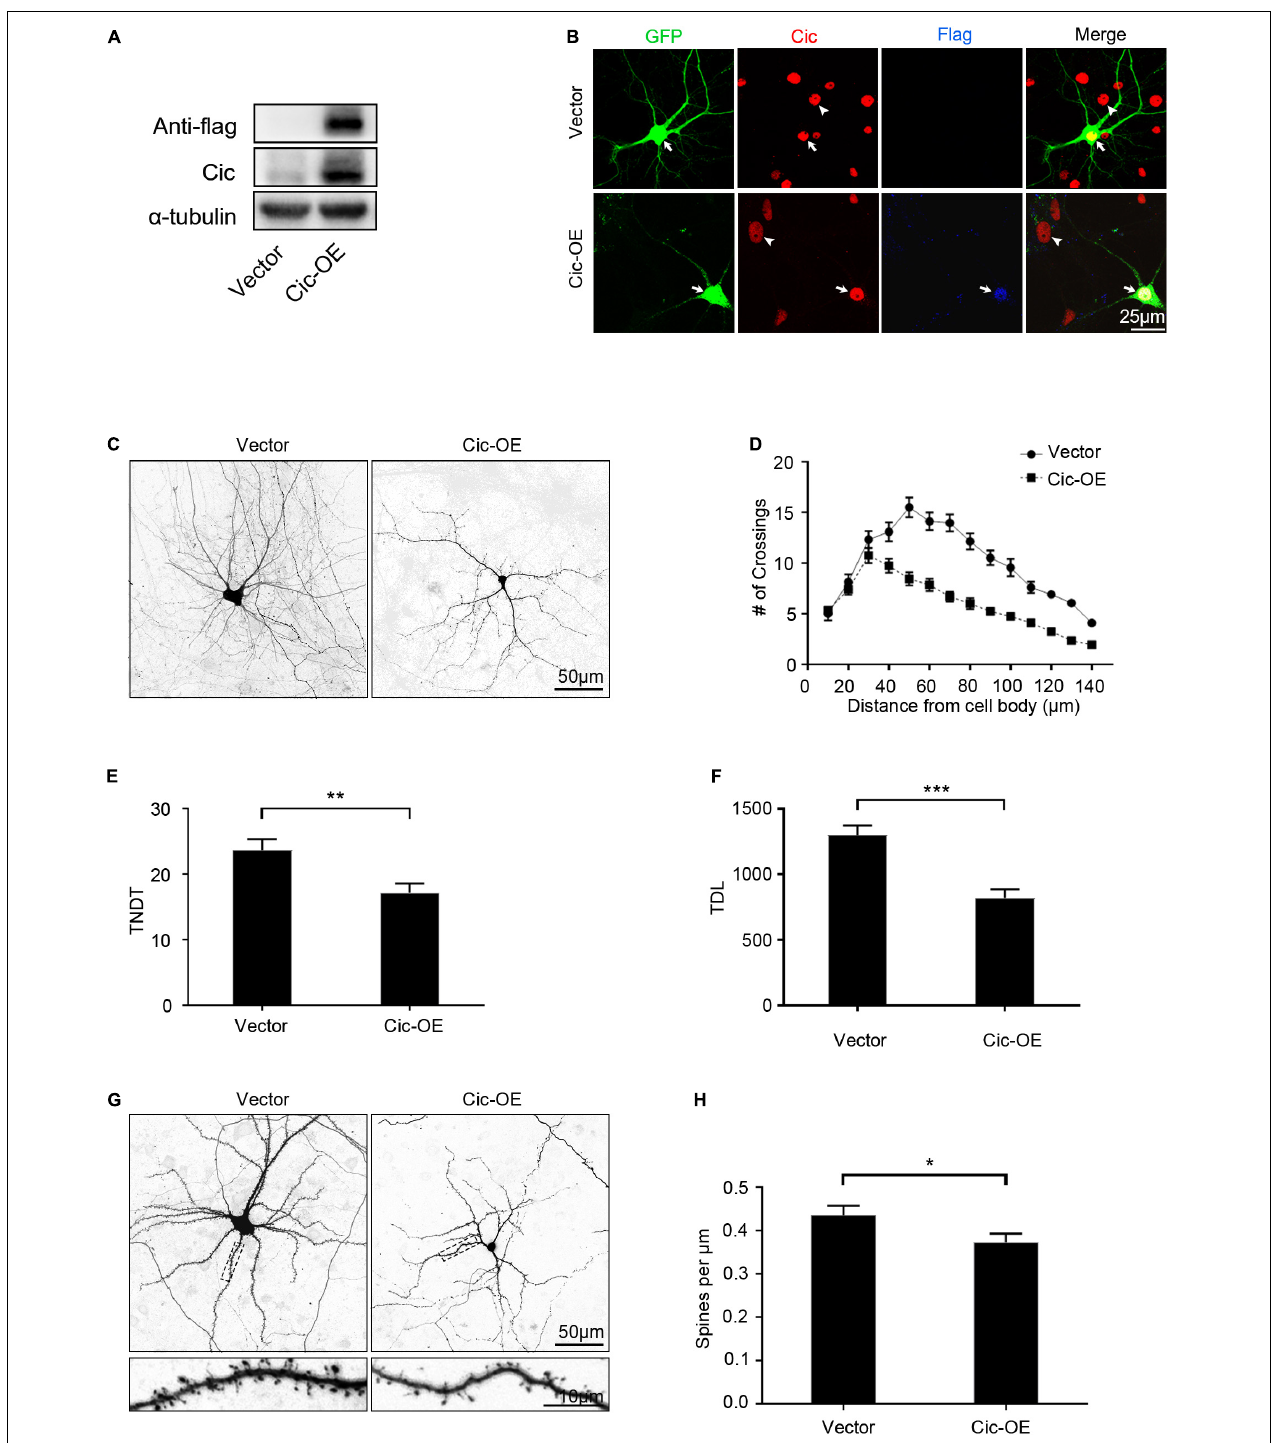
FIGURE 3 | Overexpression of Cic in hippocampal neurons suppresses dendrite and dendritic spine growth in vitro . (A) The Cic protein expression level in HT22 cells after Cic-OE or empty vector transfection was detected by western blot. (B) Hippocampal neurons cultured in vitro were transfected on DIV 7 for 6 days with either control vector or Cic-OE-GFP. Afterward, the cells were stained with antibodies against Cic and Flag, the arrow indicates transfected neurons, and the arrowhead indicates untransfected cells. (C) Representative images of deisolated neurons transfected on DIV 7 for 7 days with vector-GFP or Cic-OE-GFP. (D–F) Sholl analysis, TNDT and TDL of deisolated neurons transfected with vector or Cic (vector: n = 50; Cic-OE: n = 50). (G) Representative images of deisolated neurons transfected on DIV 7 for 14 days with vector or Cic-OE. (H) Quantification of dendritic spine densities (vector: n = 36; Cic-OE: n = 36). Cell images were obtained from three independent culture batches. Error bars indicate SE. *** p < 0.001; ** p < 0.01; * p < 0.05.